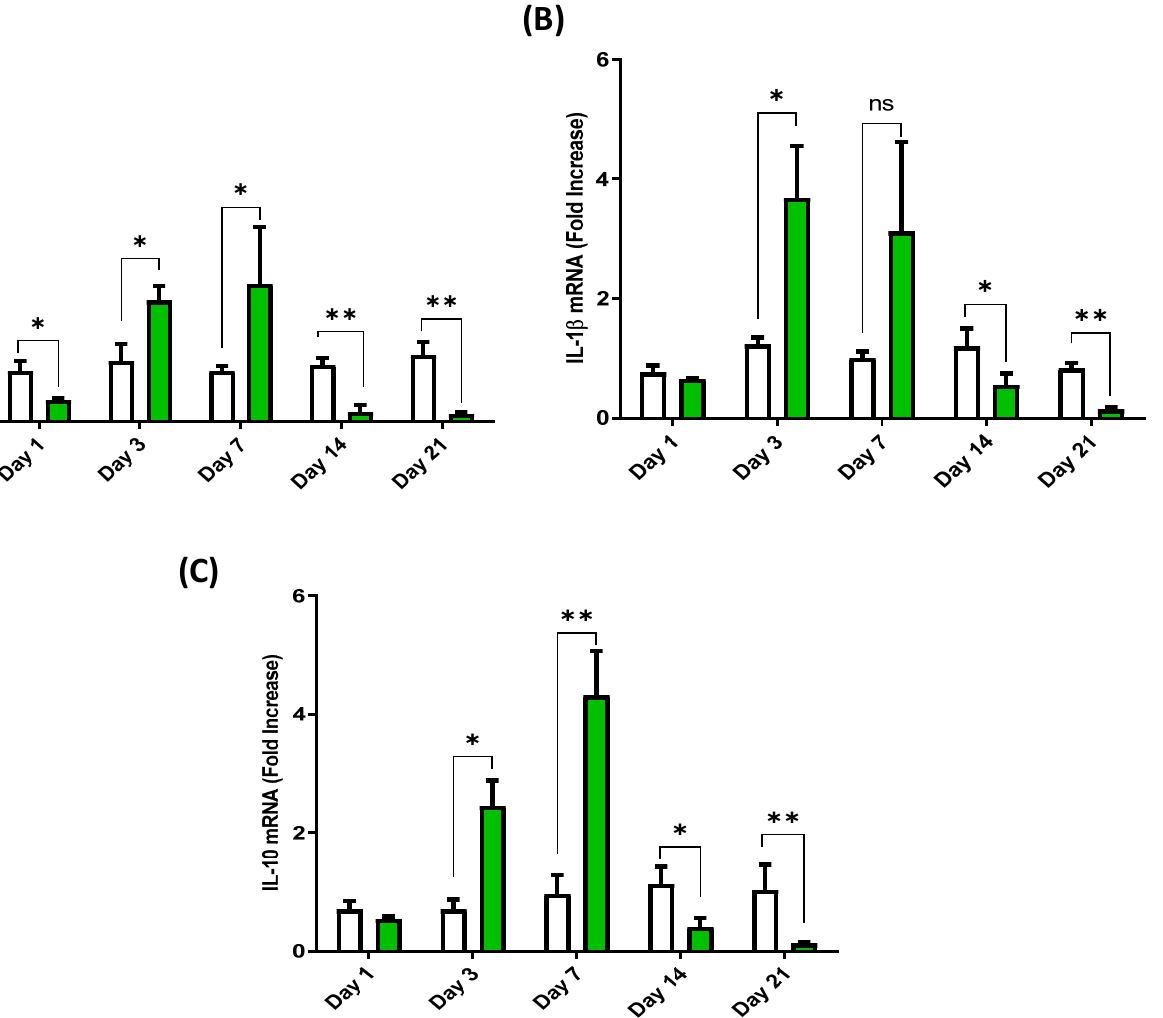
Figure 2. Anterior intestine cytokine mRNA expression profile of European sea bass injected with Hep20. TNF α ( A ), IL-1 β ( B ) and IL-10 ( C ) mRNA expression in the anterior intestine of European sea bass after Hep20 intraperitoneal injection (green bars). The graph shows the cytokine fold induction compared to the control group, i.e., fish injected with phosphate-buffered saline (white bars). Significant differences ( p < 0.05 or p < 0.01) between groups at each time are indicated by (*) or (**) respectively ( n = 6), ns (non-significant